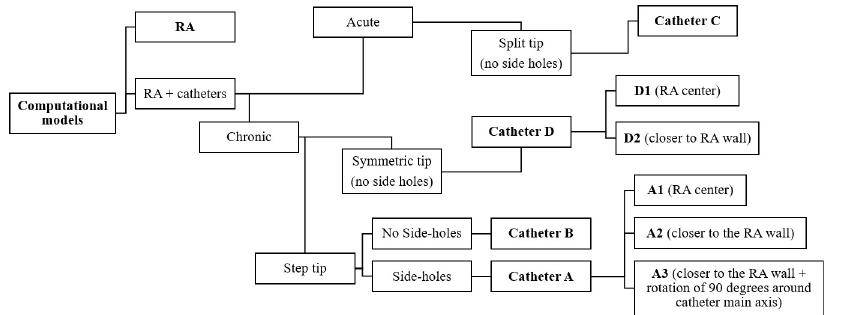
Fig 3. Diagrammatic overview of all computational models developed. Acute refers to temporary catheter placement and chronic to permanent catheter placement, this is of relevance to the clinical use of the catheters.